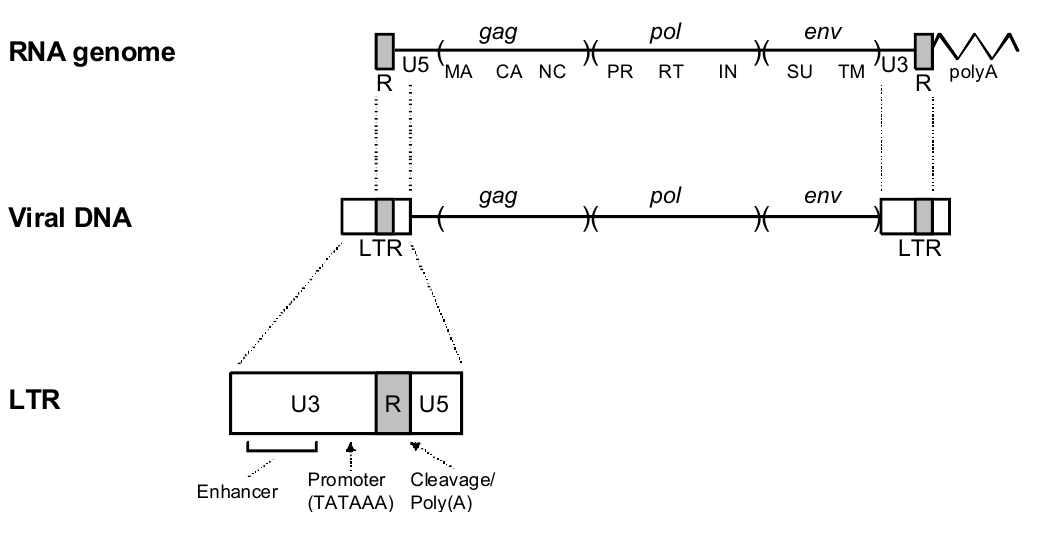
Figure 2. Retroviral LTRs. The relationship of retroviral RNA to the reverse transcribed DNA is shown. The viral RNA contains short direct repeats at either end (R), and the viral DNA contains long terminal repeats. Subdivision of the LTR into U3, R and U5 regions is shown at the